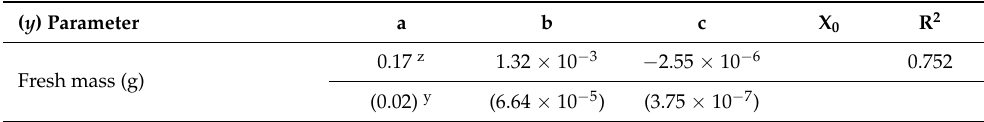
Figure 1. Fresh mass ( A ), dry mass ( B ), dry matter concentration ( C ), leaf number ( D ), stem diameter ( E ), and height ( F ) of 14-day old butterhead lettuce ‘Rex’ ( Lactuca sativa ) seedlings grown under light intensities of 60, 100, 200, 400, or 600 µmol·m − 2 ·s − 1 for a 24-h photoperiod. Each symbol represents the mean of 30 plants ± SE. Lines represent linear, quadratic, or quadratic plateau regression. Equations and significance are reported in Table 3. Table 3. Regression analysis parameters and R 2 for butterhead lettuce ‘Rex’ ( Lactuca sativa ) growth, development, and carotenoid and chlorophyll concentrations and content at transplant in response to seedlings grown under light intensities of 60, 100, 200, 400, or 600 µ mol · m − 2 · s − 1 for a 24-h photoperiod for 14 d. x = photosynthetic photon flux density ( PPFD ; µ mol · m − 2 · s − 1 ). X 0 = light saturation